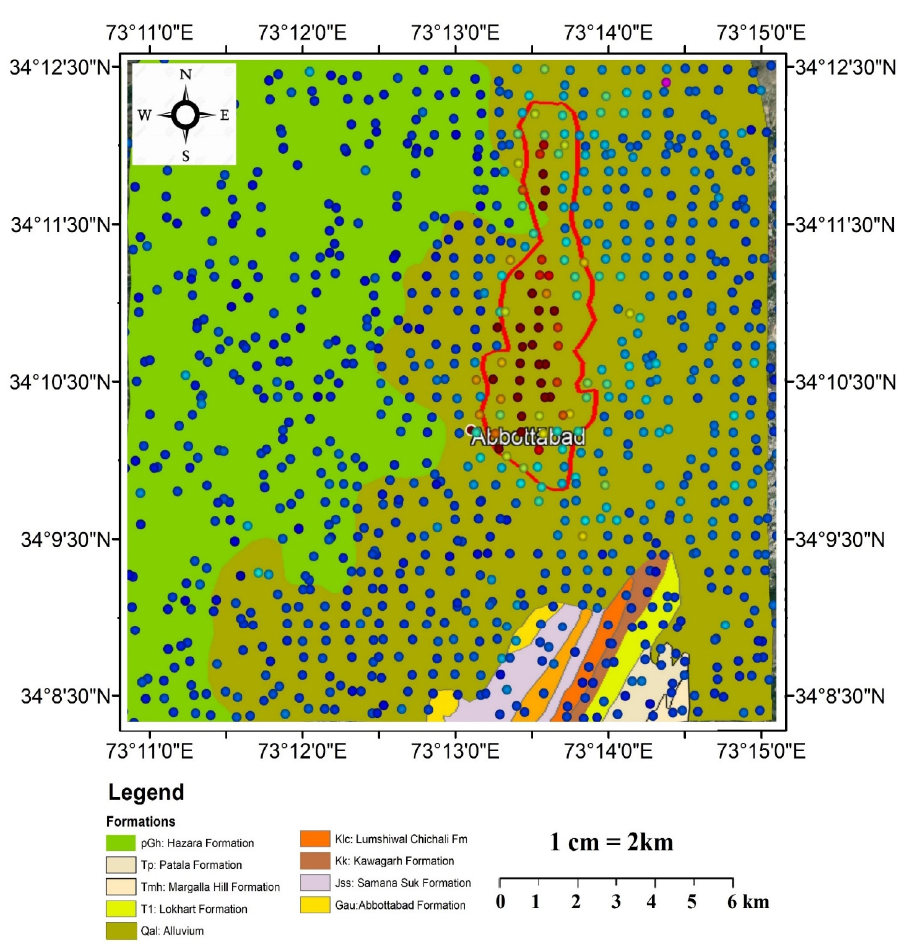
Figure 16. Permanent scatterers on the geological map.